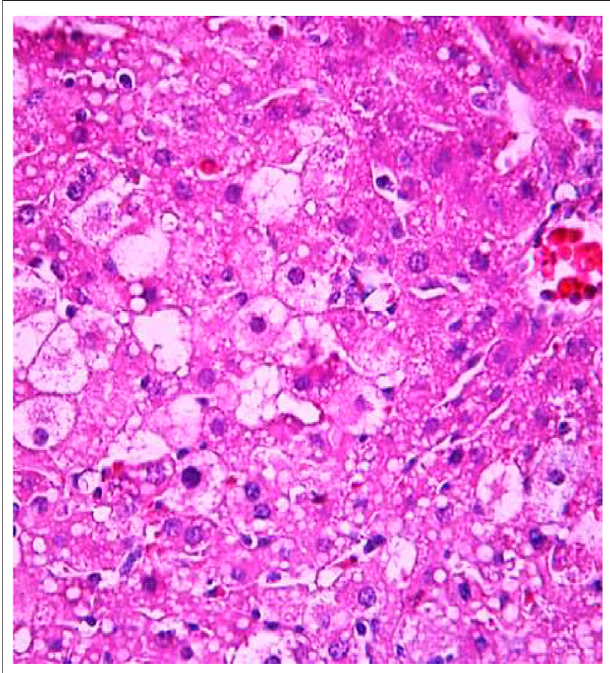
FIGURE6| Livertissue.Positive controlgroup . Fullness oftheperiportal vessels. Hydropic and vacuolar dystrophy of hepatocytes of the periportal zones ofthehepatic lobule. Stain:hematoxylinand eosin.Magni fi cation × 200.